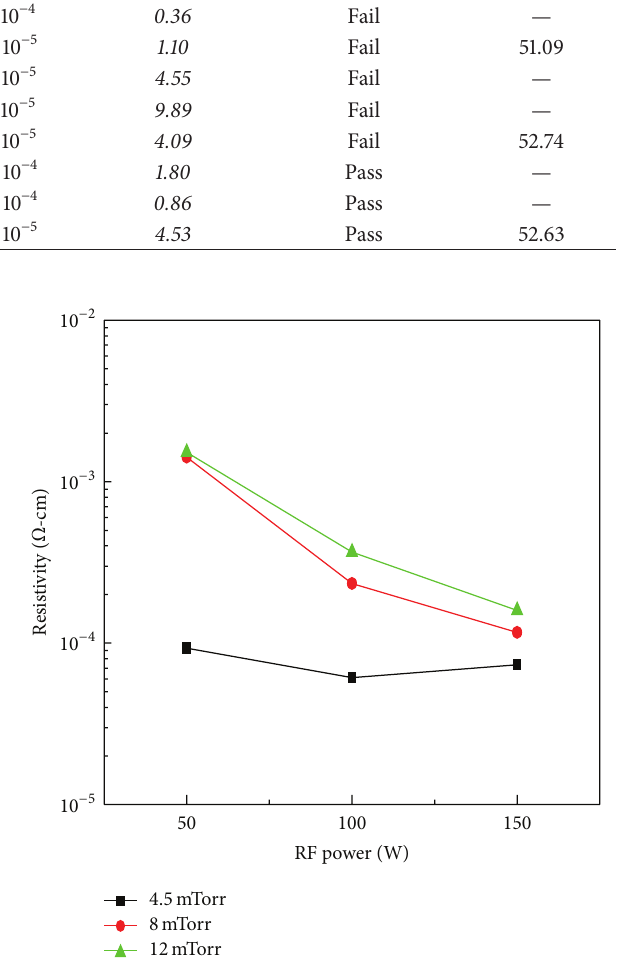
Figure 3: Resistivities of Mo films prepared at different RF sputter- ing powers and working pressures.